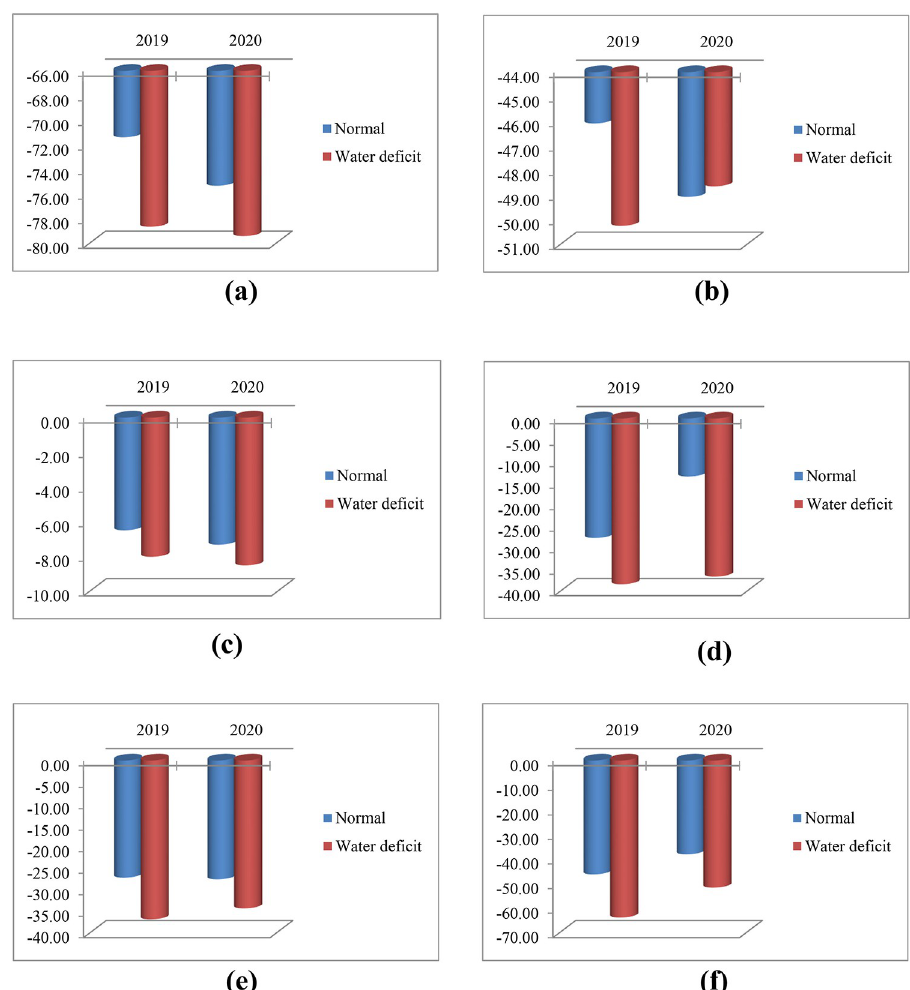
Fig 4. Percentage of inbreeding depression for (a) seed yield per plant (SYP); (b) essential oil content (EOC); (c) relative water content (RWC); (d) carotenoid content (CAR); (e) chlorophyll a content (Chl a ); and (f) chlorophyll b content (Chl b ) under two years (2019 and 2020) and two moisture conditions (normal and water